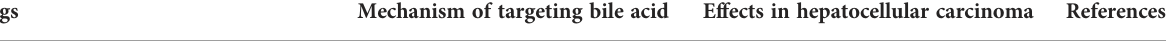
TABLE 1 Drugs targeting dysregulated bile acids in